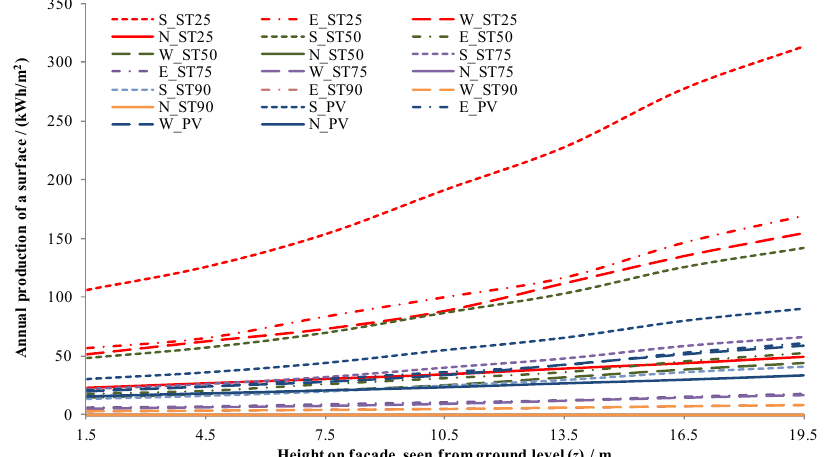
Figure 6. The annual energy production as a function of height from